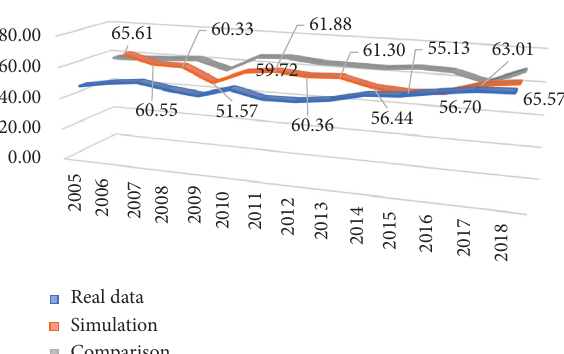
Figure 7: Uncertainty in the simulation of the high water